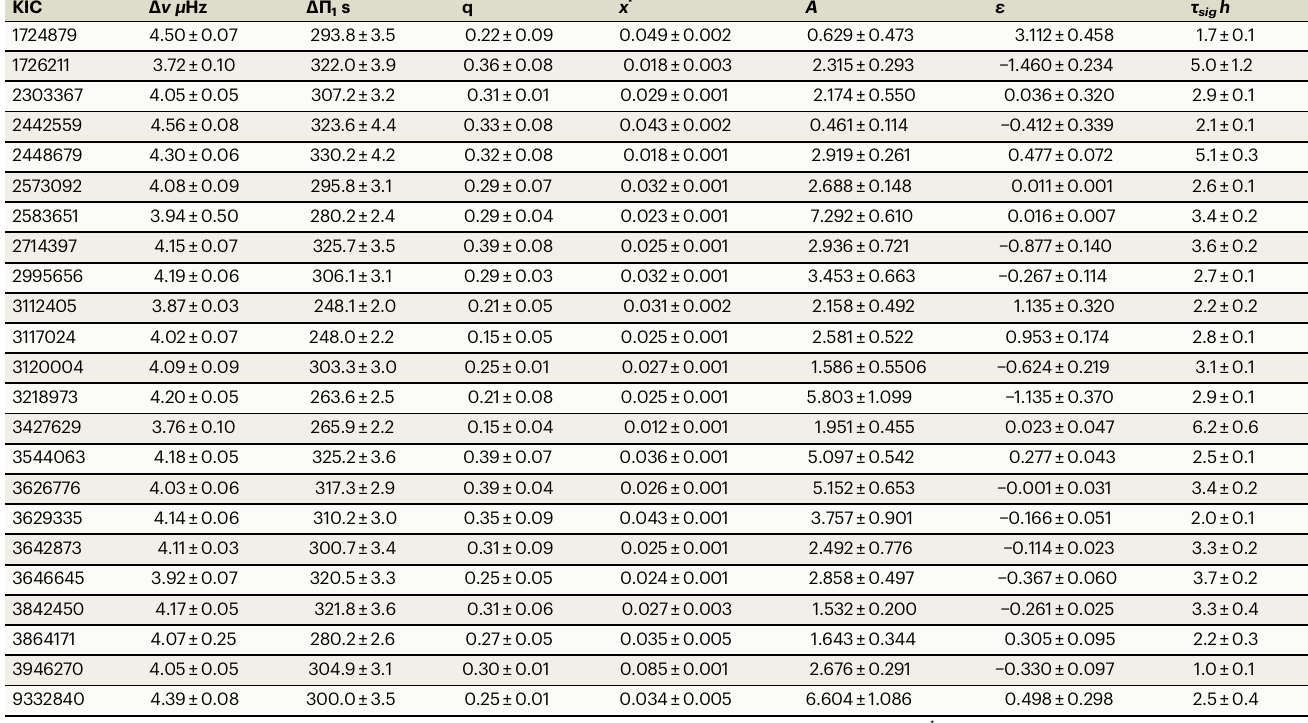
Table 1 | Properties of the stars exhibiting a core-glitch signature KIC Δ ν μ